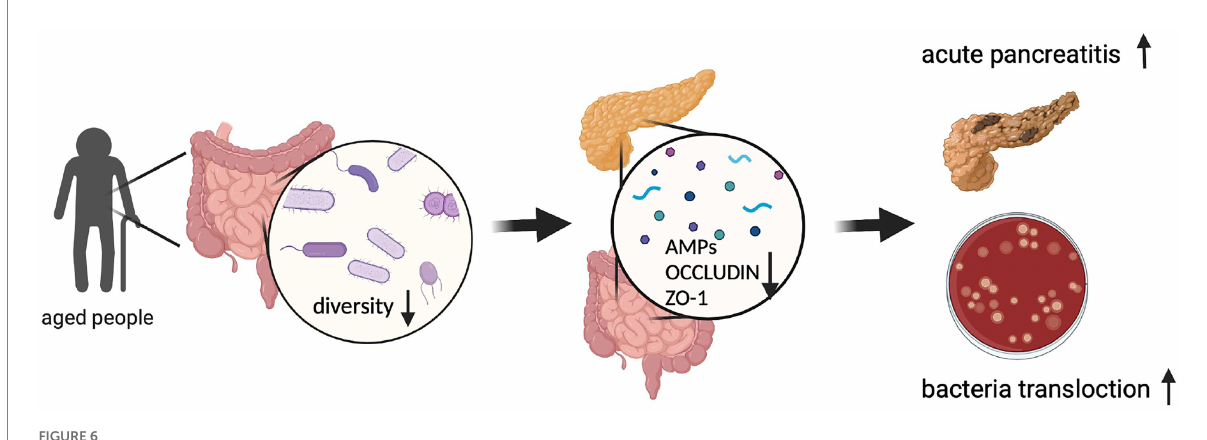
FIGURE 6 Graphic abstract. (Created with